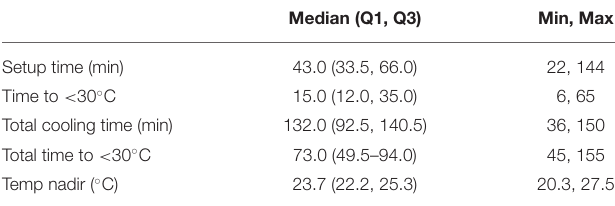
TABLE 2 | Selective hypothermia parameters achieved in 17 animals.